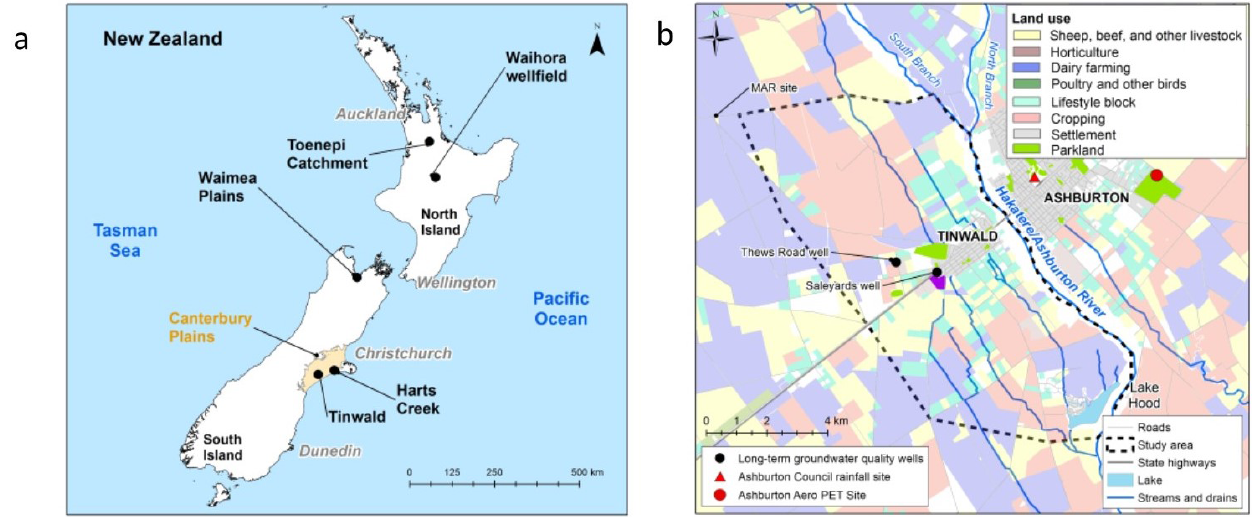
Figure 1. (a) New Zealand map showing locations of Tinwald and other areas mentioned in the text. (b) Tinwald study area with simplified land usage (Agribase, 2016). Base map containing road and stream information © LINZ (2019). PET: potential evapotranspiration.